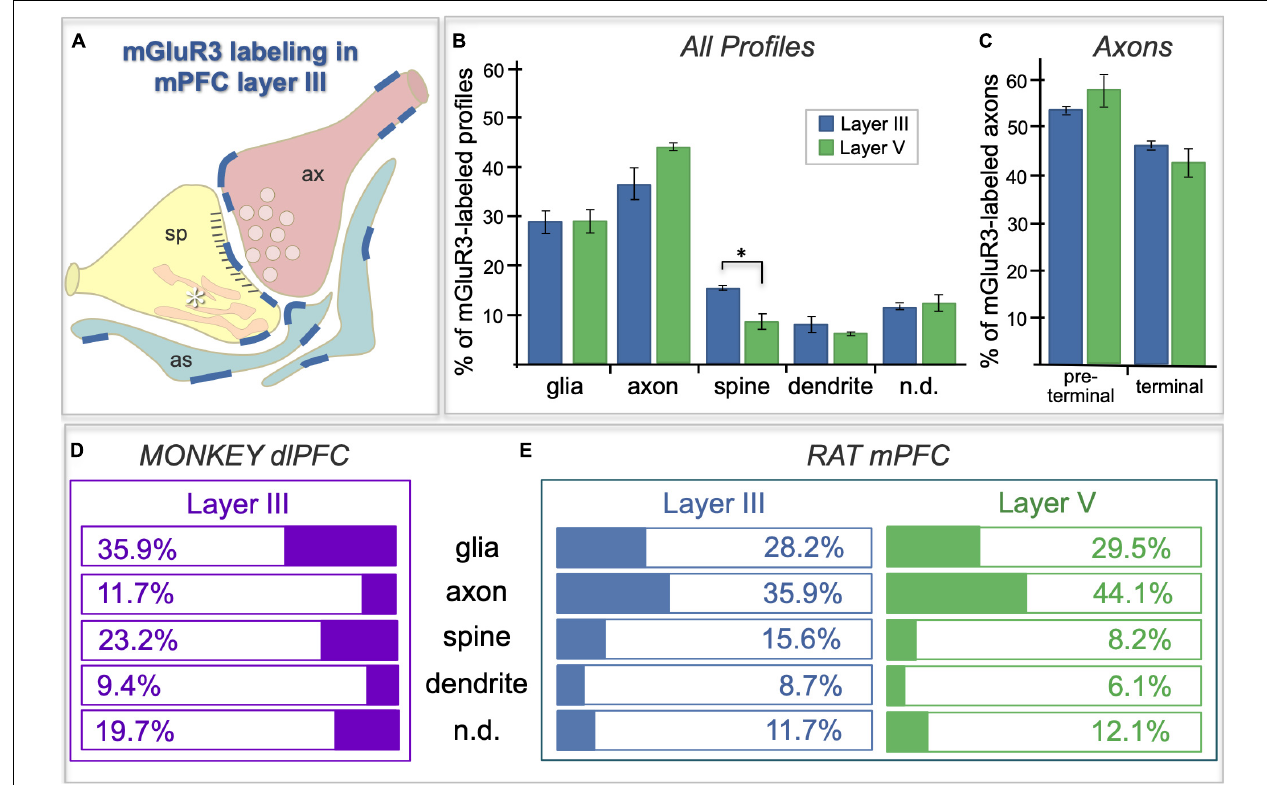
FIGURE 7 | Frequency of mGlu3-labeled profiles in layer II/III vs. V of rat PL mPFC, and a comparison to the pattern in macaque. (A) Schematic of the localization patterns of mGlu3 in rat PL mPFC layer II/III; labeling represented by dark blue lines. Sp = spine, ax = axon terminal, as = astrocyte, asterisk indicates the calcium-containing SER spine apparatus. (B) Bar graphs of the average frequency of mGlu3-containing cellular profile types, expressed as a percentage of the total number of immunoreactive profiles, in layer II/III vs. V of rat PFC. In addition to the classical astroglial expression, mGlu3 are concentrated presynaptically in axons in both layers. mGlu3 are also expressed in spines, with significantly more expression in layer II/III than in layer V. (C) Immunoreactive axonal profiles in rat PFC are further classified into preterminal and terminal categories. A numerically larger proportion of mGlu3-labeled axons are preterminal compared to terminal in the two layers, which did not differ from one another. For (B,C) , group results are expressed as the mean ± SEM. ∗ p < 0.05. n = 3 rats. (D,E) Comparison of mGlu3 expression patterns in rhesus macaque layer III dlPFC (D) with that in rat PL mPFC layers II/III and V (E) . mGlu3 predominate on glia (presumed astrocytes) and spines in monkey, but on axons in